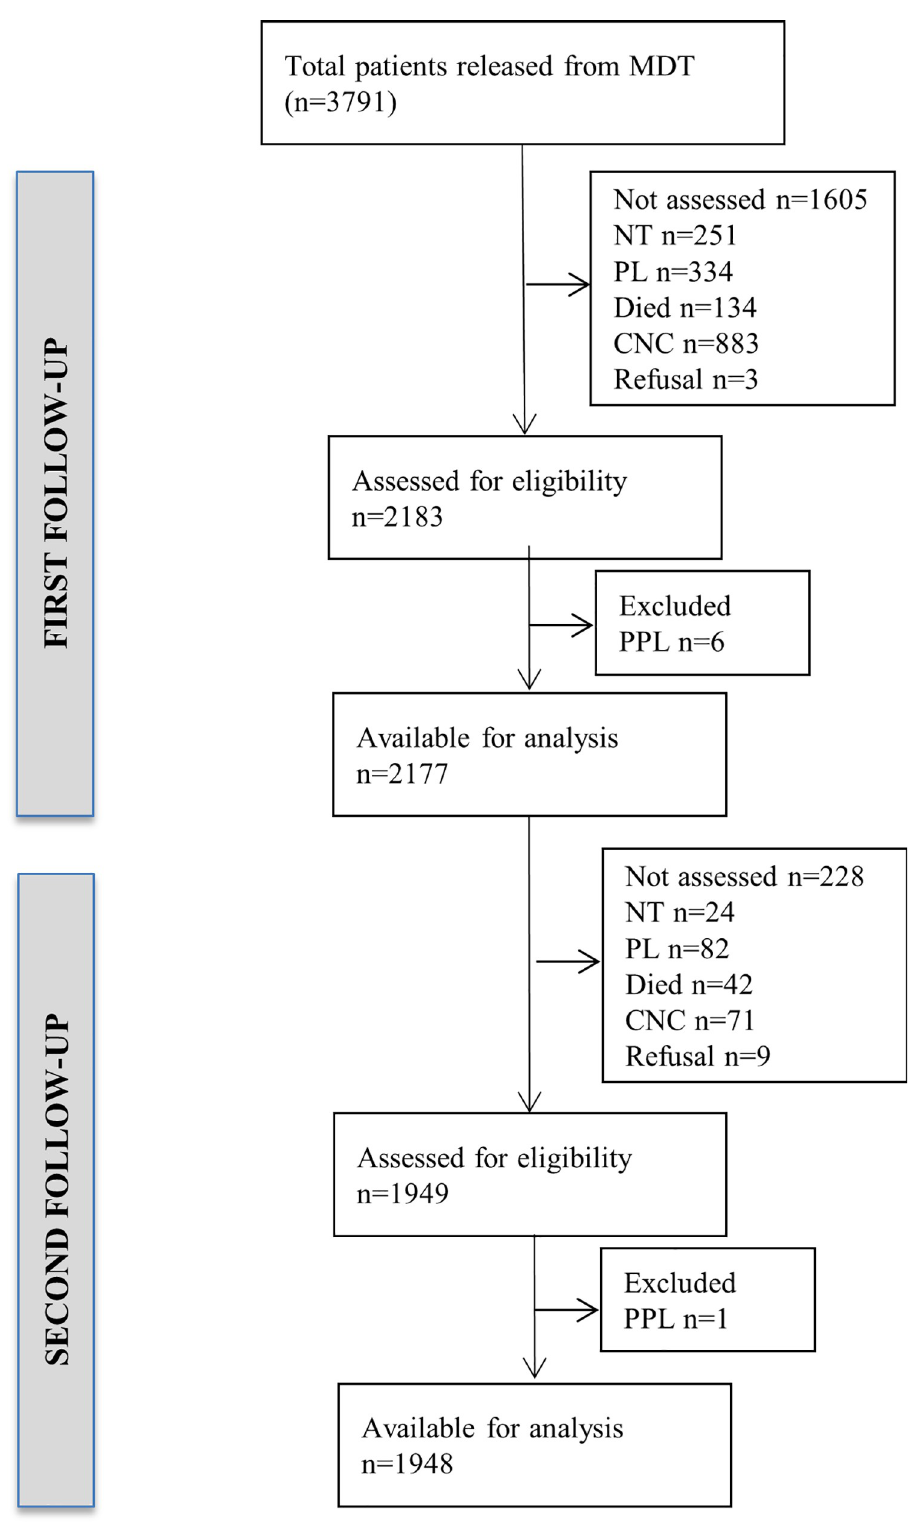
Fig 1. Recruitment process of RFT patients in first and second follow-up surveys in study districts: Relapse and deformity among patients released from National Leprosy Eradication Programme of India: A cohort study from four districts in South India. RFT–Released from treatment; NT–Not traceable; PL–Permanently left; CNC–Could not be contacted; PPL–Patients with persistent leprosy. https://doi.org/10.1371/journal.pntd.0009950.g001 PLOS NeglectedTropical Diseases | https://doi.org/10.1371/journal.pntd.0009950 November23,